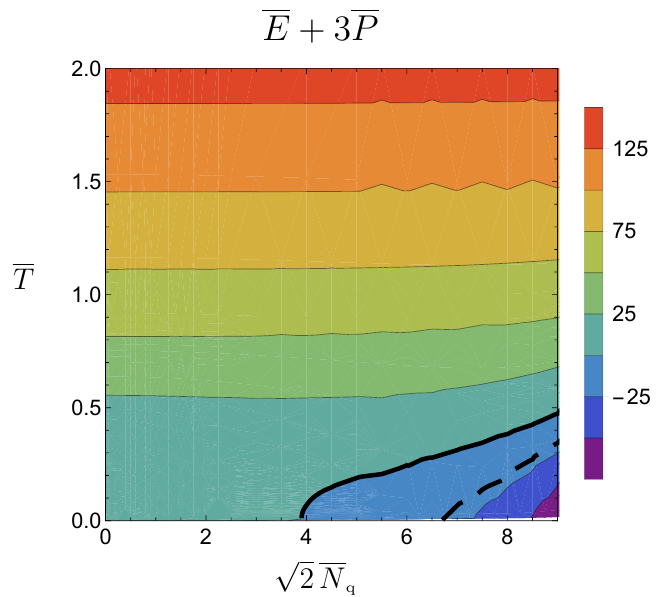
Figure 20. Contour plot of the combination E + 3 P . The thick, black, continuous curve indicates the locus where this quantity changes sign. For comparison, we have also indicated with a thick, black, dashed curve the locus where E + P changes sign (see also (cid:12)gure